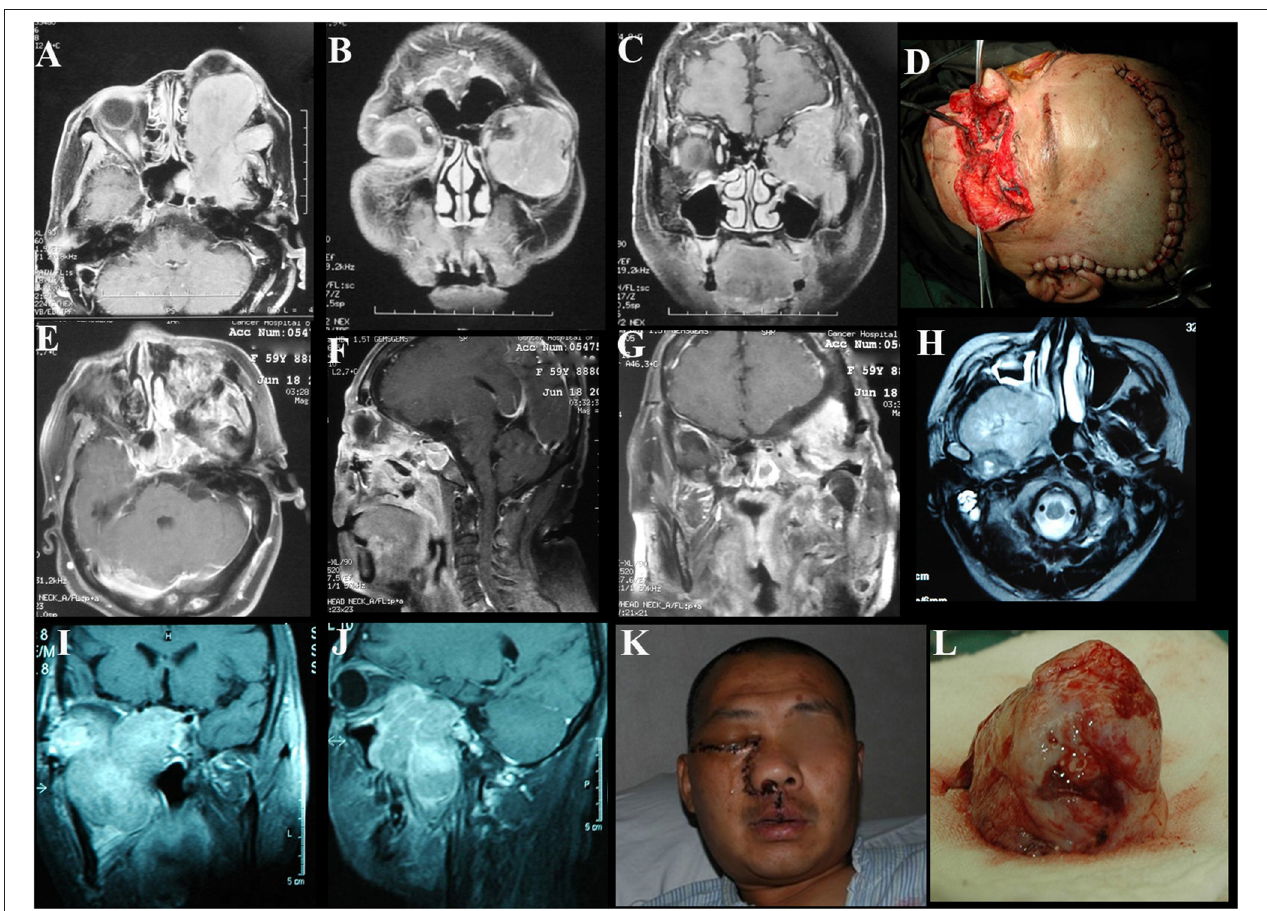
FIGURE 4 | Case illustrating the craniofacial and maxillary swing approaches. (A–C) T1-weighted axial and coronal contrast-enhanced MRIs demonstrate a tumor with homogeneous enhancement located in the anterior and lateral cranial base with extension to the orbits and infratemporal fossa. (D) The incision of the craniofacial approach. (E–G) Contrast-enhanced MRIs 1 week after the surgery indicate satisfactory tumor resection. (H–J) T1-weighted axial, coronal, and sagittal contrast-enhanced MRIs demonstrate a middle skull base meningioma extended into the right infratemporal and pterygopalatine fossae with significant enhancement. (K) The incision of the maxillary swing approach. (L) Photograph of the tumor sample. The maxillary swing approach can provide wide exposure and allow en bloc tumor resection.